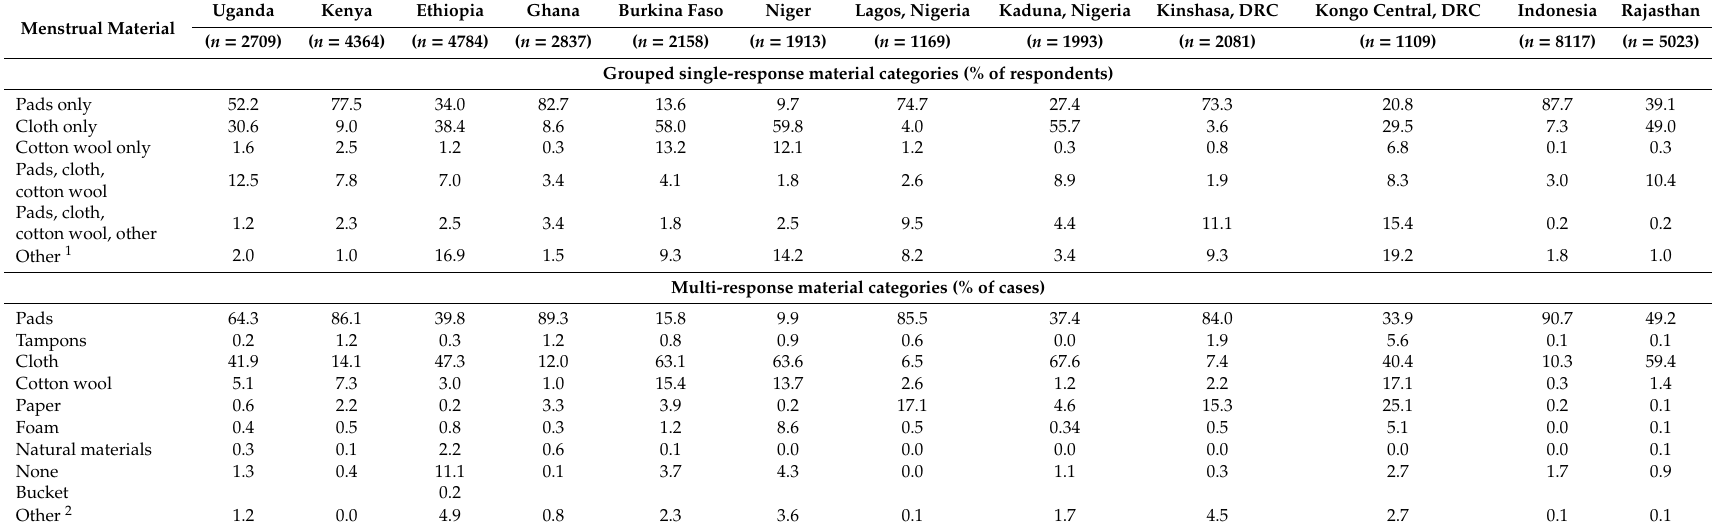
Table 1. Reported menstrual material use by country. Material use is categorized using both a single-response and a multi-response